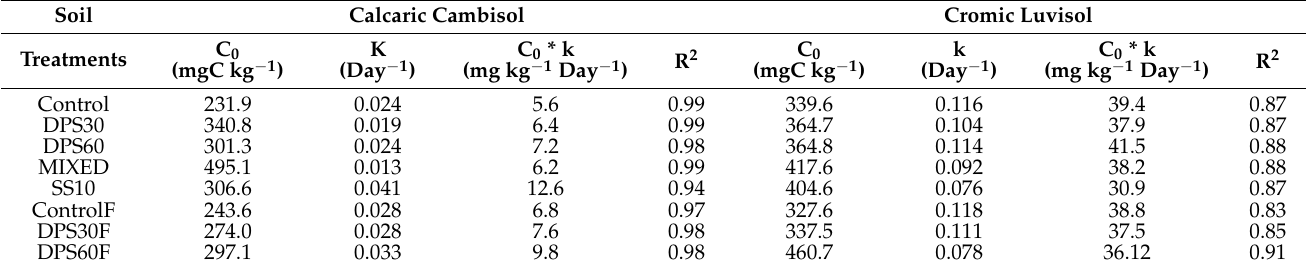
Table 5. Kinetic parameters of carbon (C) mineralization according to the exponential model calculated as C t = C 0 (1 − e ( − kt) ) using Curve Expert Professional software. Soil Calcaric Cambisol Cromic Luvisol